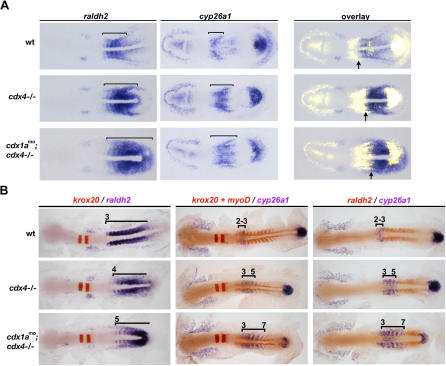

cdx Genes Regulate the Expression Boundaries of raldh2 and cyp26a1
(A) Expression of raldh2 and cyp26a1 in wild-type, cdx4–/– mutants, and cdx-deficient embryos by whole-mount in situ hybridization. Brackets indicate raldh2 and cyp26a1 expression domains in the anterior paraxial mesoderm of 5 somite stage embryos. Right column is an overlay of the raldh2 and cyp26a1 expression patterns, arrows indicate the anterior boundary of the presumptive RA source.(B) Double whole-mount in situ hybridization showing co-staining of krox20, myoD, raldh2, and cyp26a1 at 10 somites in wild-type, cdx4–/– mutants, and cdx-deficient embryos (gene names are color-coded to match their staining product). Brackets and numbers indicate raldh2 and cyp26a1 expression domains and somite position, respectively